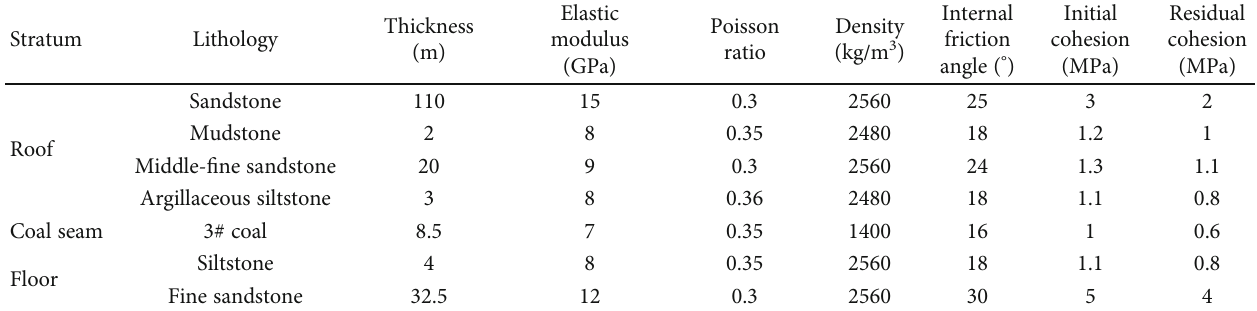
Table 1: Mechanical parameters of coal seam and rock